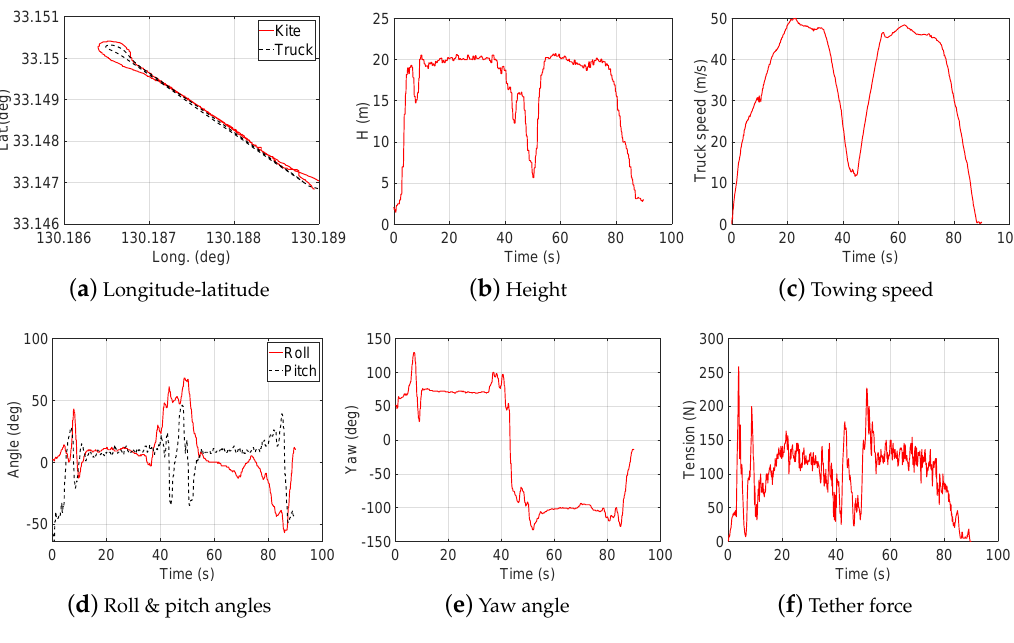
Figure 17. Data for test